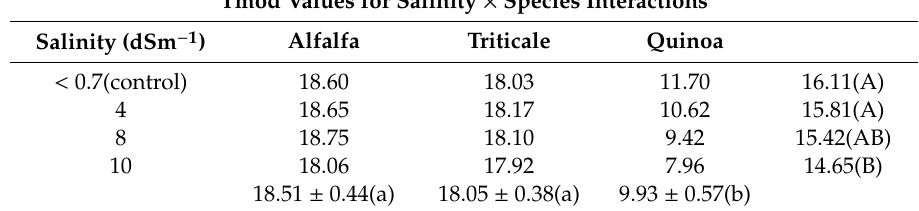
Table 5. Germination Experiment. Tmod for salinity × species interaction for alfalfa, triticale, and quinoa at four di ff erent salinity